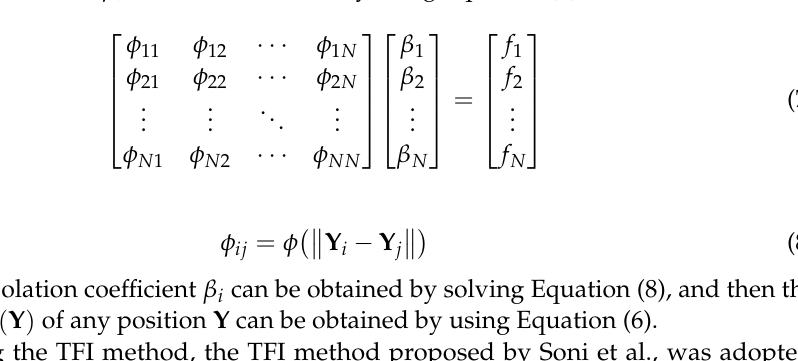
Figure 1. The grid updating procedure of the RBF-TFI method. Radial basis function interpolation can be expressed as: